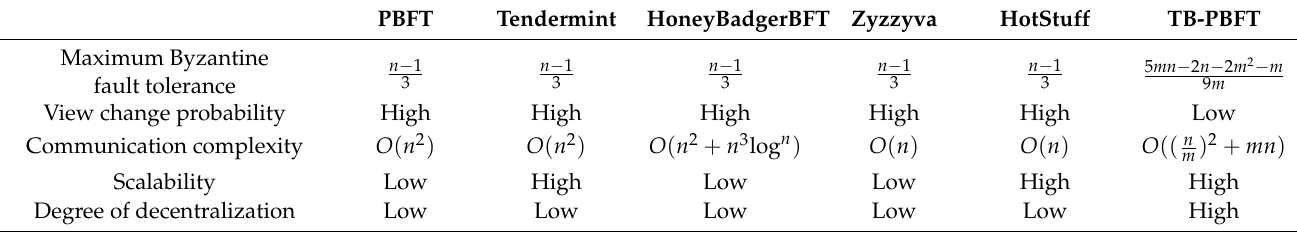
Table 1. Comparisons of TB-PBFT with other BFT-type consensus algorithms.